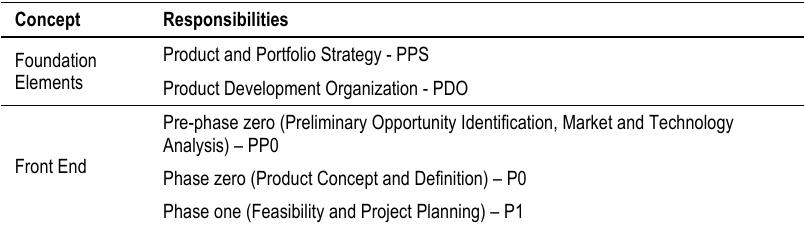
Table 5. The Three Phase Front End